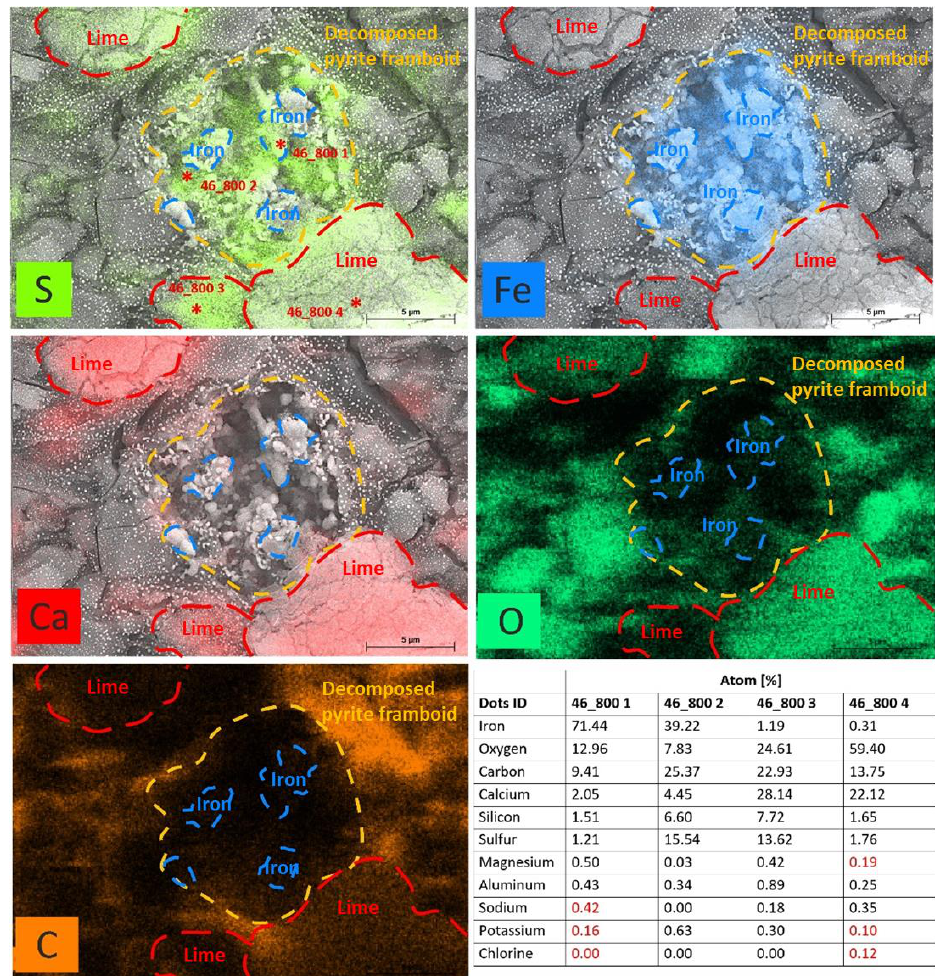
Figure 4. ( A ) Sample Ch-46t XRD patterns before the experiment and after heating at temperatures of 400 °C, 600 °C, and 800 °C. ( B ) Evolution of mineral composition during the experiment.